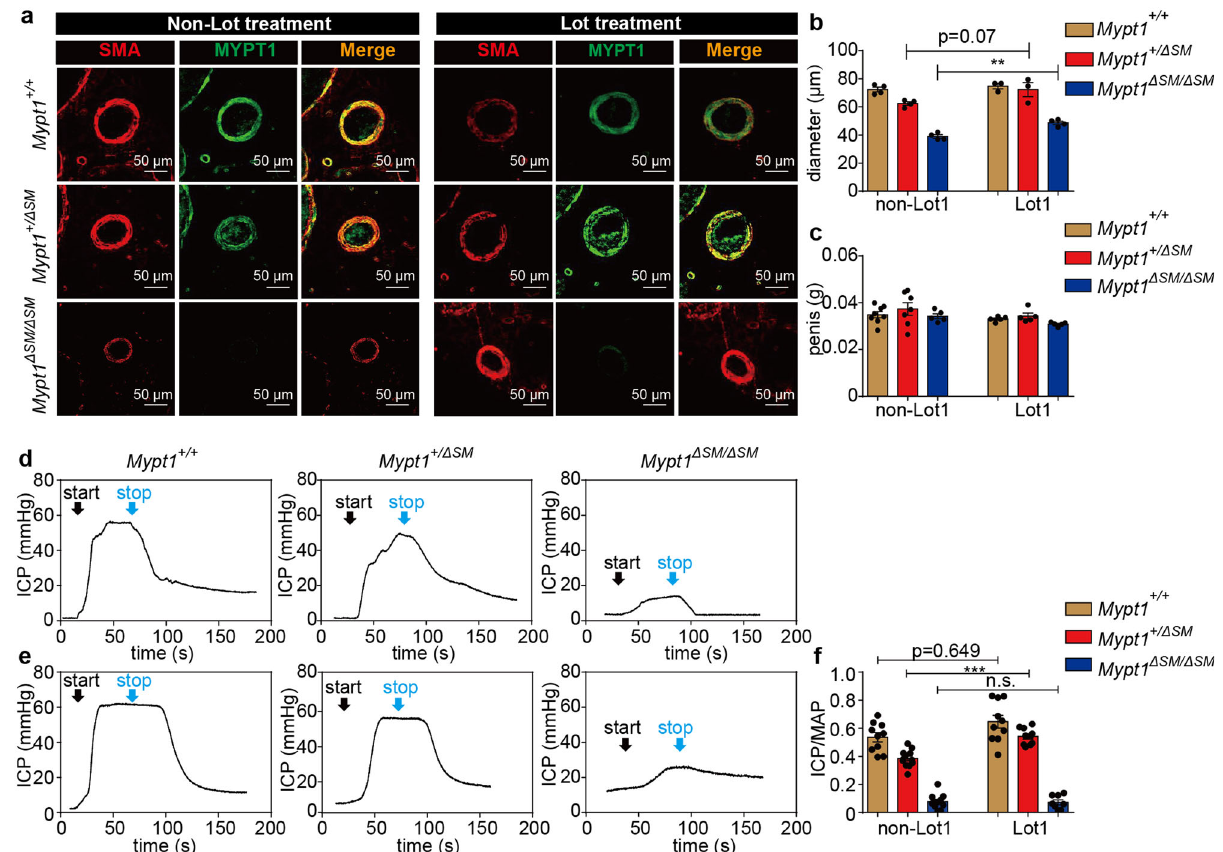
Fig. 6 Lotusine improved the penile ICP response to EFS in MYPT1 haploinsuf fi ciency mice. a Immuno fl uorescence staining showed an increase in the lumen sizes of the penile dorsal artery after lotusine treatment, and quantitation of the diameters is presented in panel b . SMA (red), smooth muscle actin, a speci fi c marker of smooth muscle; MYPT1 (green) (Panel b : Mypt1 + / + , n = 4; Mypt1 + / Δ SM , n = 4; Mypt1 Δ SM / Δ SM , n = 3). c , Quantitation of penis weights in the different groups of mice (non-Lot1: Mypt1 + / + , n = 8; Mypt1 + / Δ SM , n = 7; Mypt1 Δ SM / Δ SM , n = 5; Lot1: Mypt1 + / + , n = 5; Mypt1 + / Δ SM , n = 5; Mypt1 Δ SM/ Δ SM , n = 5). d – g , MYPT1-de fi cient mice showed decreased ICP responses to EFS of the cavernous nerve. d and e , Representative tracings of ICP responses in Mypt1 + / + , Mypt1 + / Δ SM , and Mypt1 Δ SM / Δ SM mice without ( d ) or with lotusine treatment ( e ). f Quanti fi cation of ICP/MAP in the different groups of mice (non-Lot1: Mypt1 + / + , n = 10; Mypt1 + / Δ SM , n = 12; Mypt1 Δ SM/ Δ SM , n = 11; Lot1: Mypt1 + / + , n = 10; Mypt1 + / Δ SM , n = 10; Mypt1 Δ SM/ Δ SM , n = 8). The groups of Lot1 were injected by Lot1 (5 mg/kg body weight) once a day and continued for 28 days. The bars indicate the mean values ±